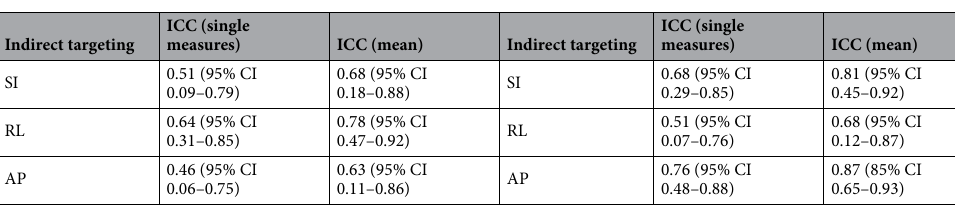
Table 2. Detailed results of ICC